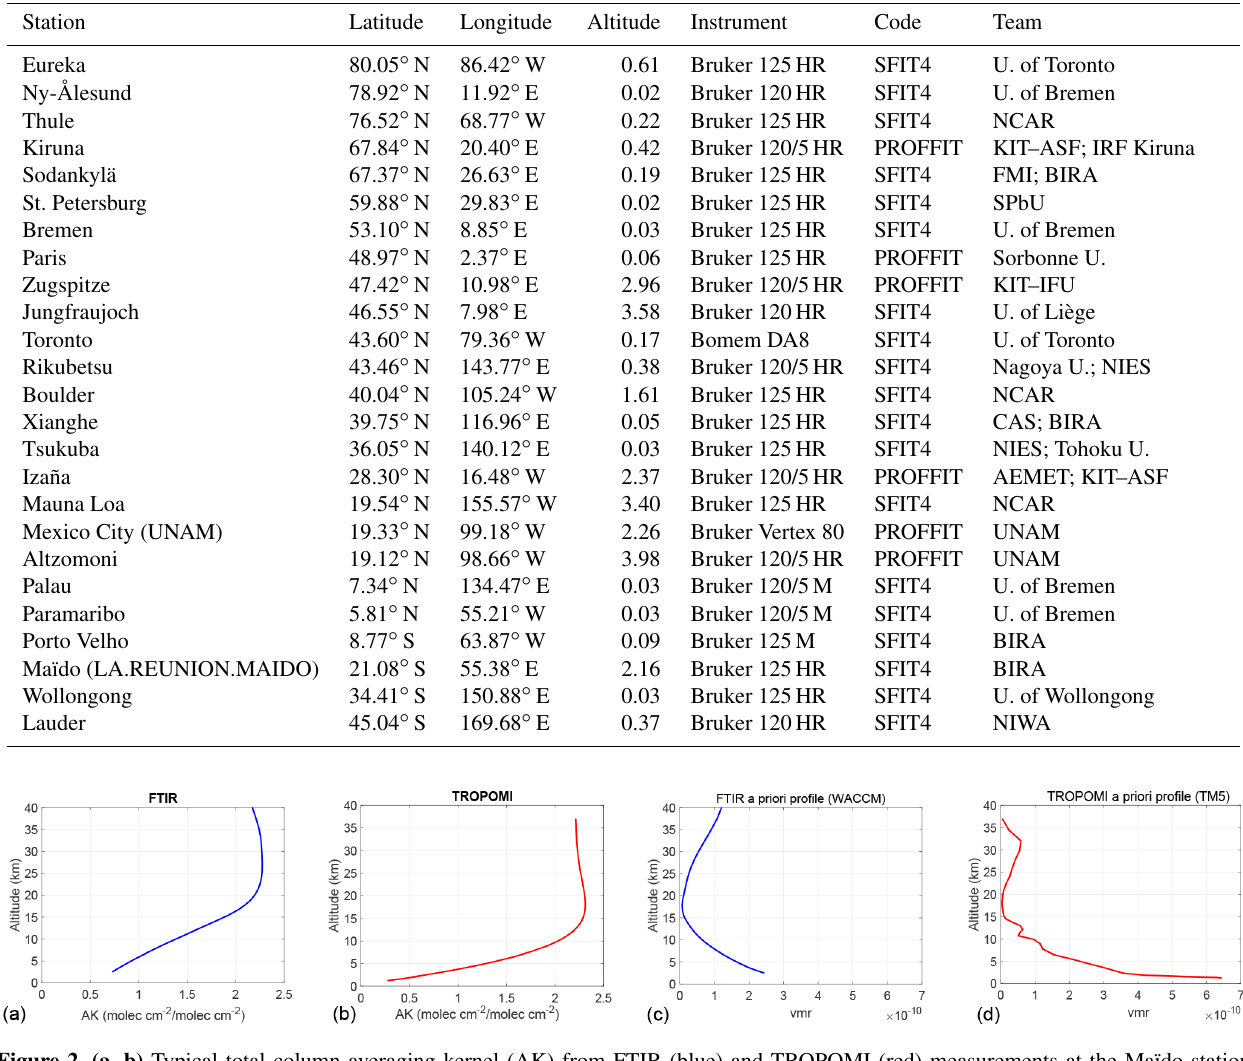
Table 2. FTIR stations that contribute to the present work: location, altitude (in kilometres above sea level), instrument type, retrieval code, and team.